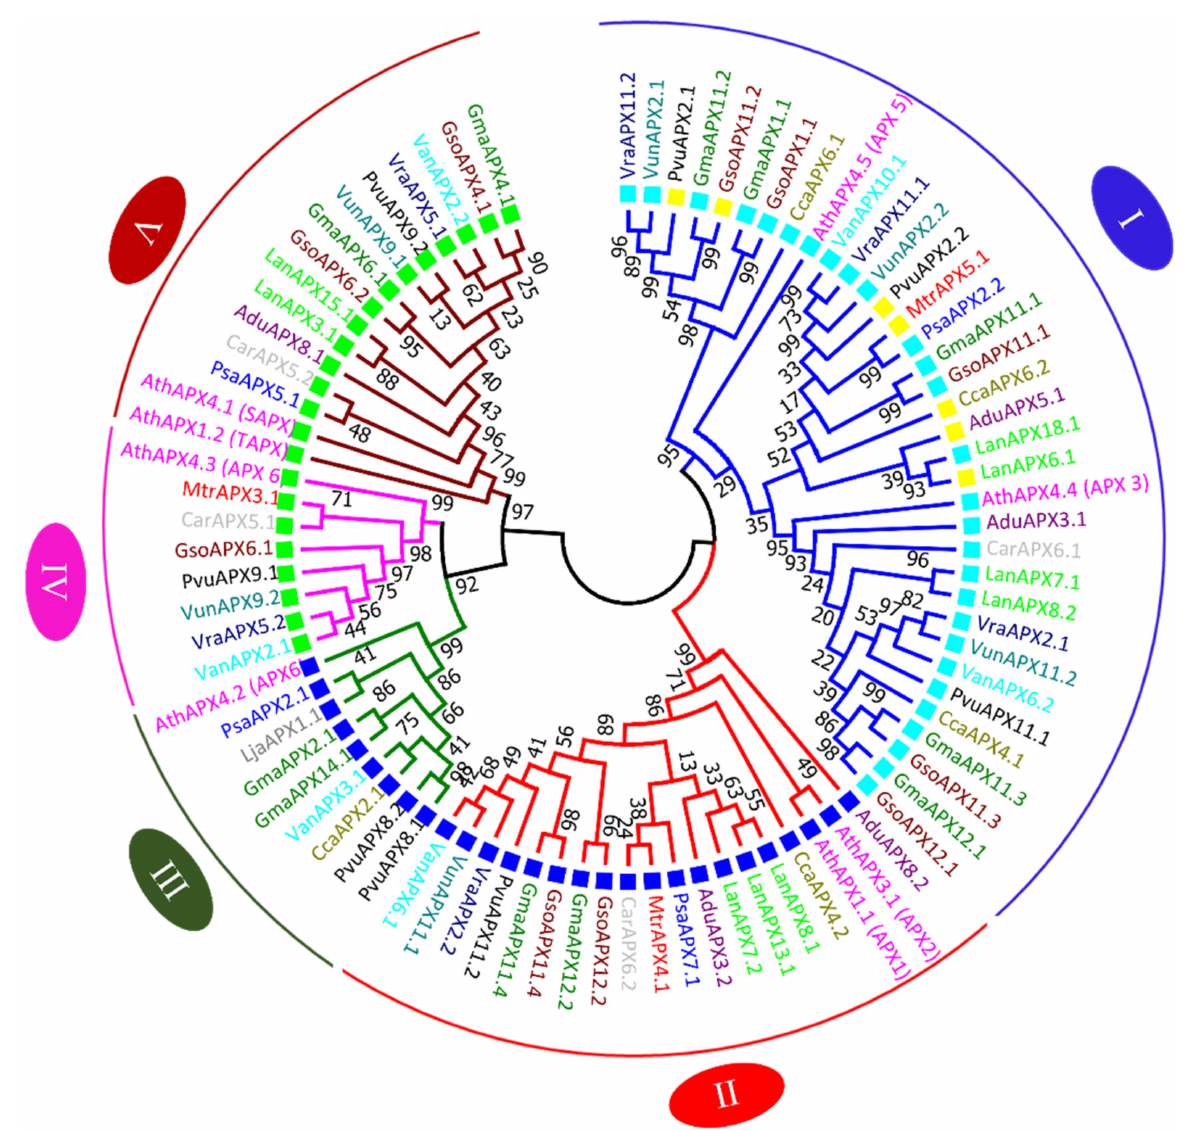
Figure 4. Phylogenic tree of APX (A) and CAT (B) proteins. The tree was constructed in MEGA 7 using the neighbor-joining method with 1000 bootstraps. Different clades of trees are marked with different colors of branch lines: Clade I (blue), Clade II (red), Clade III (green), Clade IV (pink) and Clade V (maroon). The square boxes represent cellular localization: peroxisome (aqua), cytoplasm (blue ), chloroplast (green) and mitochondria